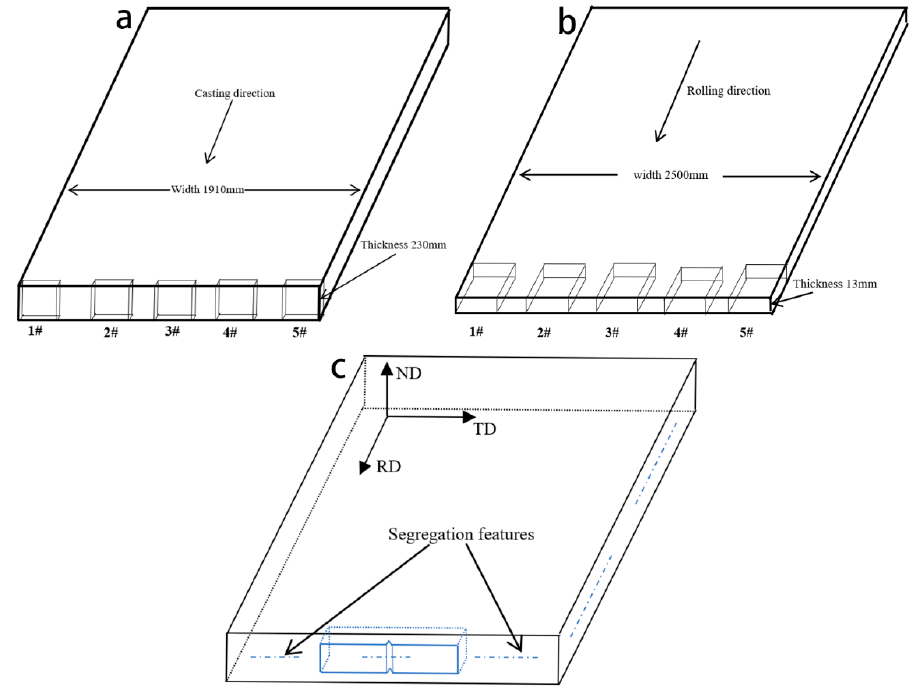
Figure 1. Sampling schematic of continuously cast slab and rolled plate: ( a ) Continuous casting slab; ( b ) rolled plate; ( c ) Charpy V-notch specimen. ( b ) rolled plate; ( c ) Charpy V-notch